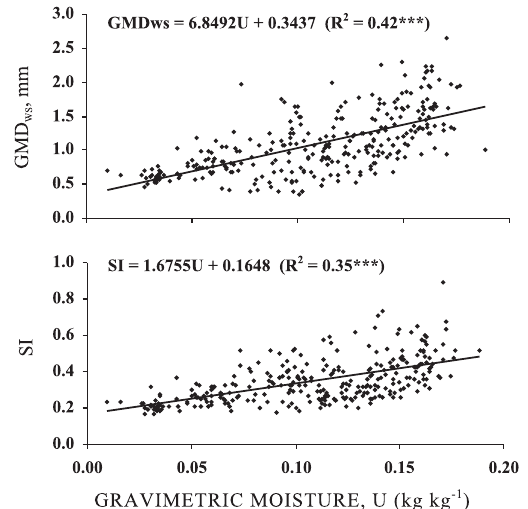
Figure 1. Correlation between gravimetric moisture (U) at the time of testing aggregate stability, with geometric mean diameter of water-stable aggregates (GMD ) and aggregate stability WS index (SI), of cores sampled in four layers after nine years under five soil tillage systems and five nutrient sources.